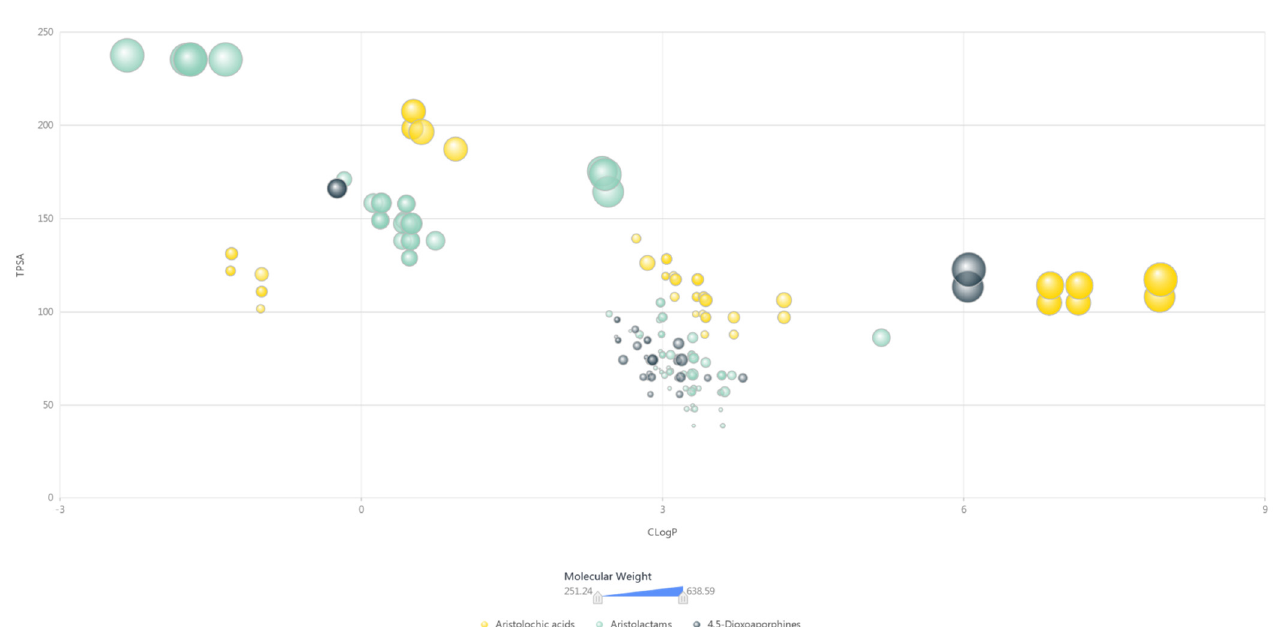
Figure 4. The scatter plot of molecular properties of aristolochic acid analogues. High-resolution image file of this figure can be found in Supplementary Materials as Figure S2.